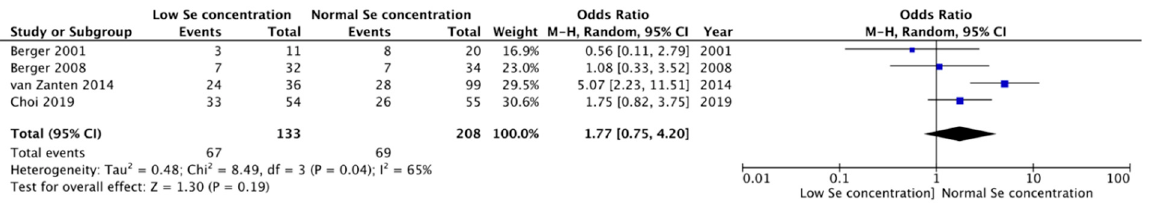
Figure 3. Forest plot of the impact of low serum Se concentration on the presence of infection of in patients with severe trauma.